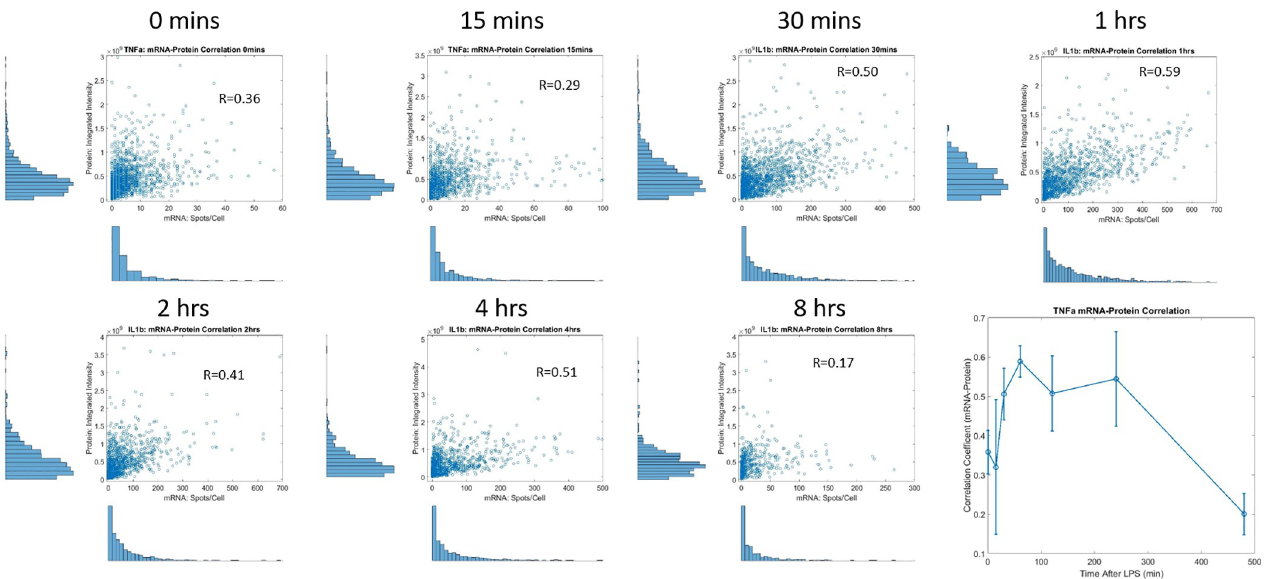
PLOS ONE | https://doi.org/10.1371/journal.pone.0215602 April 19,